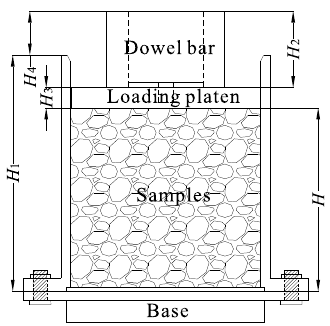
Figure 4. Original filling height of the samples before loading.